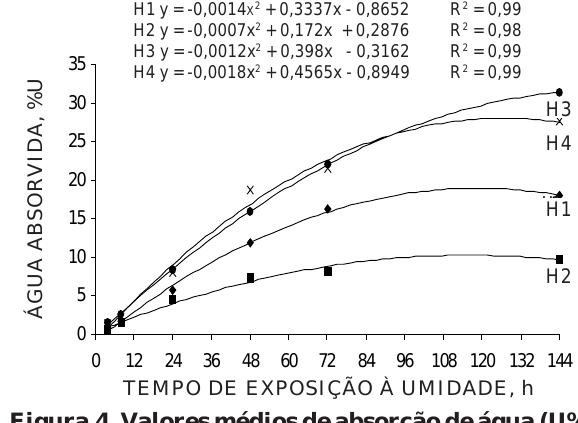
Figura 4. Valores médios de absorção de água (U%) pelas misturas de fertilizantes, considerando o tempo de exposição à umidade relativa de 85,1 %.